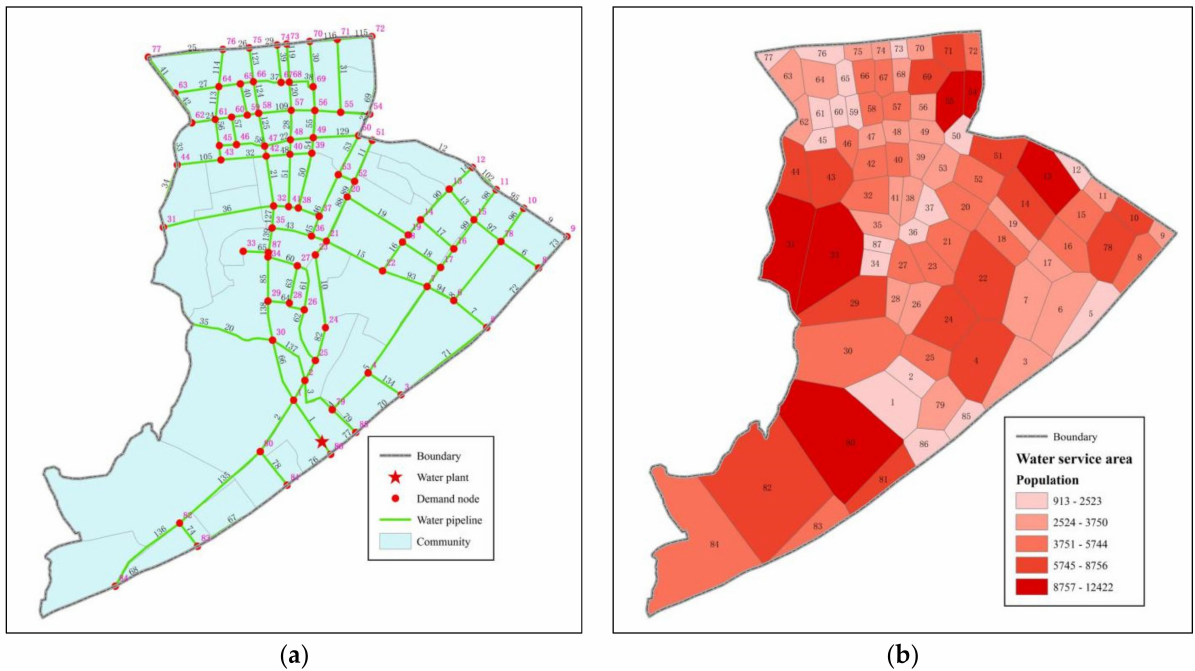
Figure 3. Water supply network and service area of different demand nodes: ( a ) plan of the water supply network; ( b ) service areas of different demand